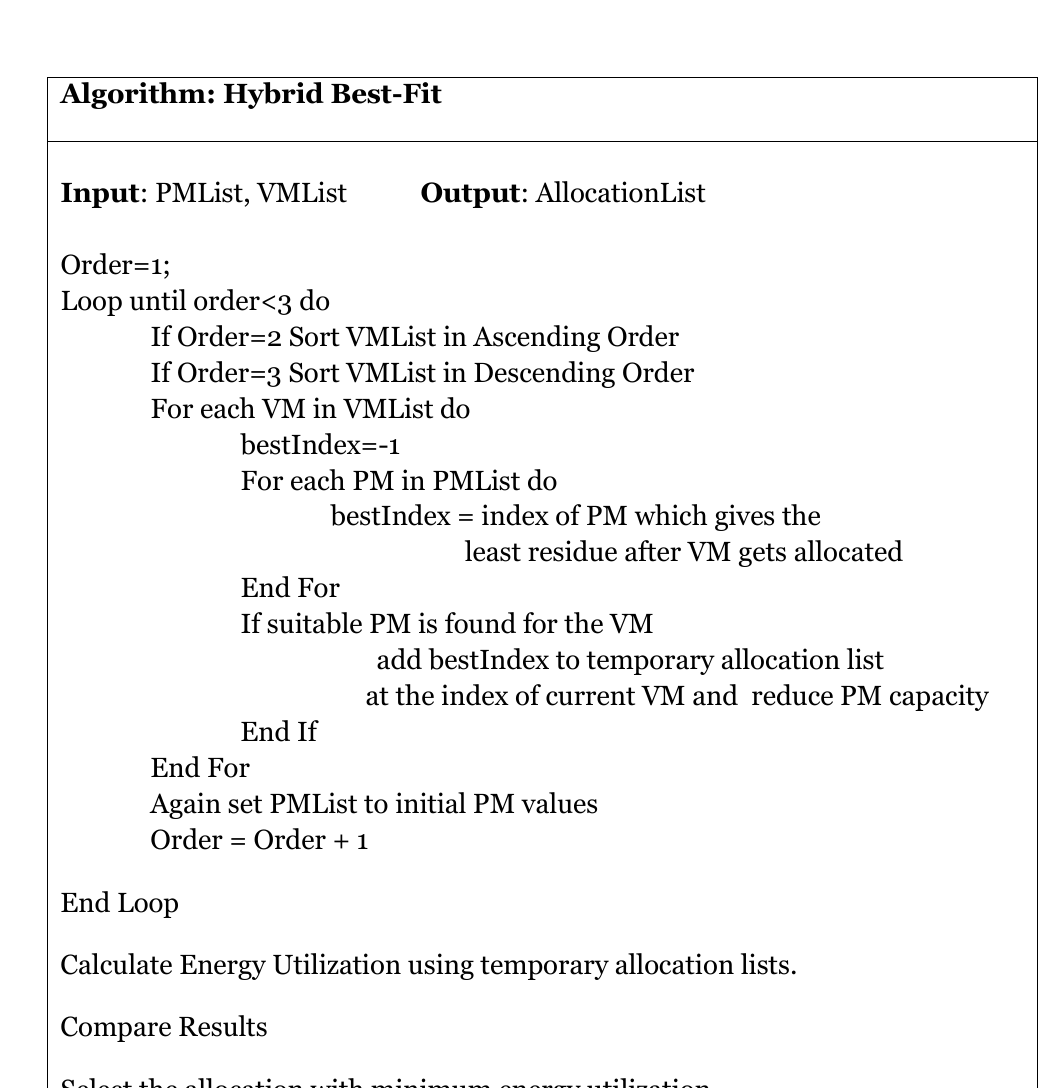
Figure 3. Hybrid Best-Fit